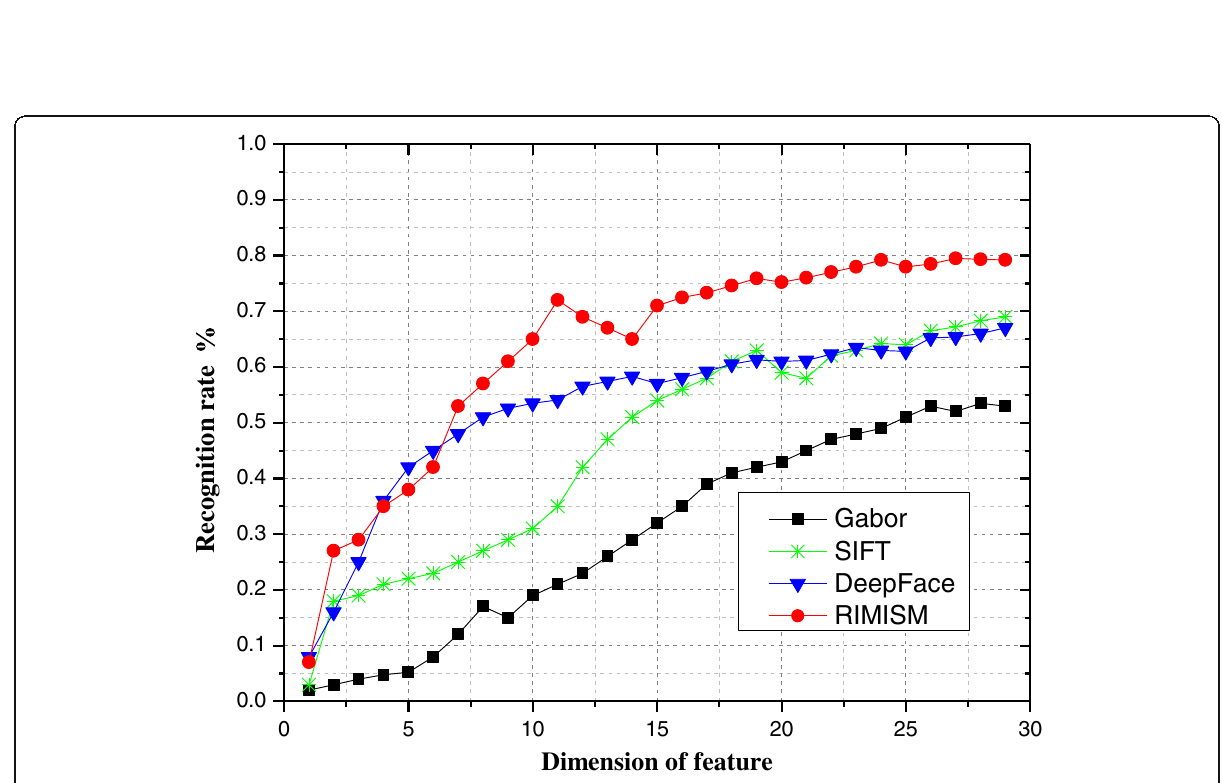
Fig. 6 Average recognition rate of ± 90° pose of FERET